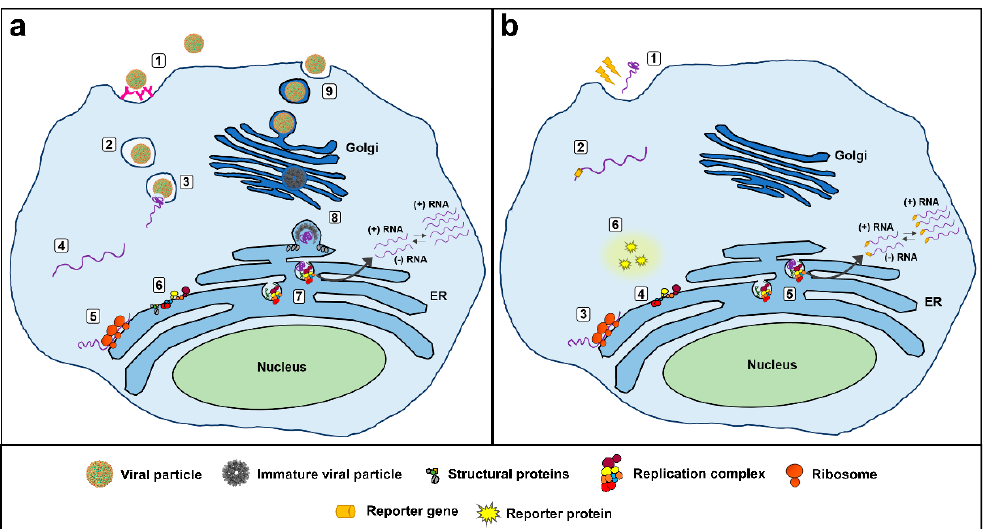
Figure 1. Schematic representation of a viral infection ( a ) compared to the transfection of cells with subgenomic RNA replicon systems ( b ). In ( a ), viral particles (1) are recognized by cell receptors and enter the cell via endocytosis (2). The acid environment of endosomes leads to the reorganization of the envelope glycoprotein (3), allowing the fusion of viral and endosomal membranes and the release of viral ( + ) ssRNA into the cytosol (4). Viral RNA hijacks the host cell’s translation machinery (5) to produce structural and nonstructural proteins (6). The nonstructural proteins assemble at the endoplasmic reticulum to form the replication complex together with host cell factors (7), allowing the viral RNA replication. Nascent viral RNA is englobed by viral structural proteins, forming immature viral particles (8). Immature viral particles travel through the Golgi apparatus, where pH and enzymatic modifications allow particle maturation and release. In ( b ) in vitro transcribed replicon RNA (1) is transfected into susceptible mammalian cells. In this case, electroporation is represented by the rays because it is the most widely used physical method able to transfect a large number of cells in a short time, as it is an easy and rapid transfection option [16]. (2) Replicon RNA harbors a reporter gene in place with structural protein genes. (3) Replicon RNA hijacks the host cell’s translation machinery to produce the reporter protein and nonstructural proteins. (4) Nonstructural proteins assemble at the endoplasmic reticulum to form the replication complex together with host cell factors, allowing the replicon RNA replication (5). (6) The reporter protein in the cytoplasm produces a fluorescent or luminescent signal that correlates with the level of accumulated replicon RNA, allowing the follow-up of the replicon replication efficiency.